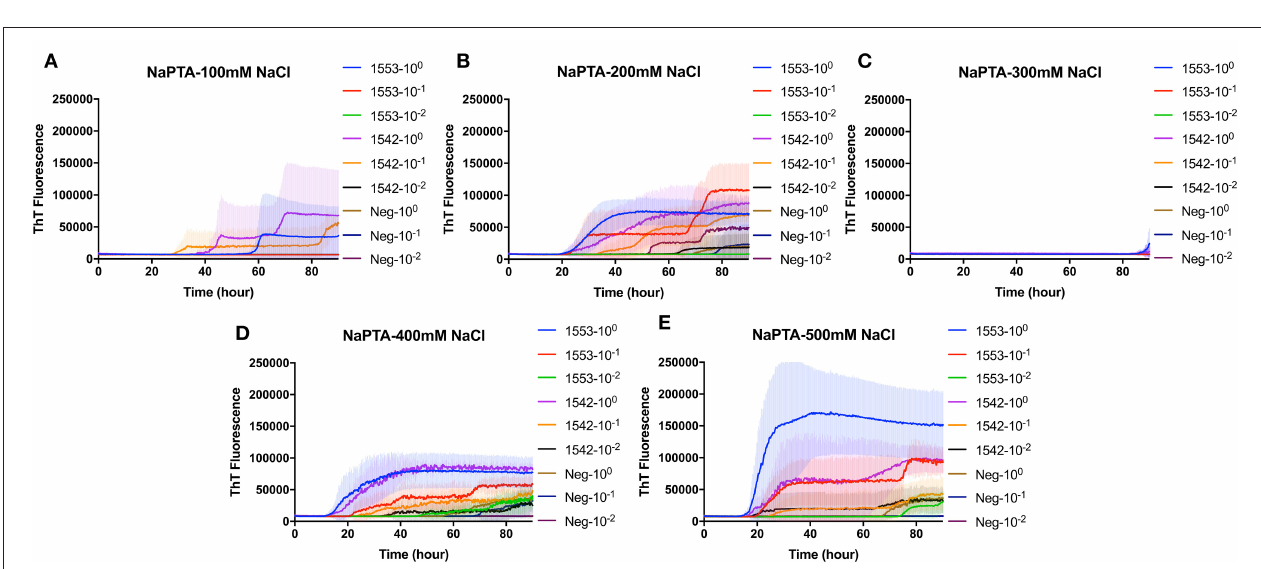
FIGURE 2 | Real-time quacking-induced conversion (RT-QuIC) reactions containing different NaCl concentrations (A) 100mM, (B) 200mM, (C) 300mM, (D) 400mM, and (E) 500mM seeded with sodium phosphotungstic acid (NaPTA) enriched fecal dilutions from CWD infected white-tailed deer brains using BV rPrP as a substrate. RT-QuIC reactions were seeded with 10 0 , 10 − 1 , or 10 − 2 dilutions of 10% fecal homogenate. All reactions were seeded with fecal homogenate of white-tailed deer with the addition of 0.001% of SDS. Shown are the average ThT fluorescence readings determined from all replicates (four replicate reactions per each dilution).